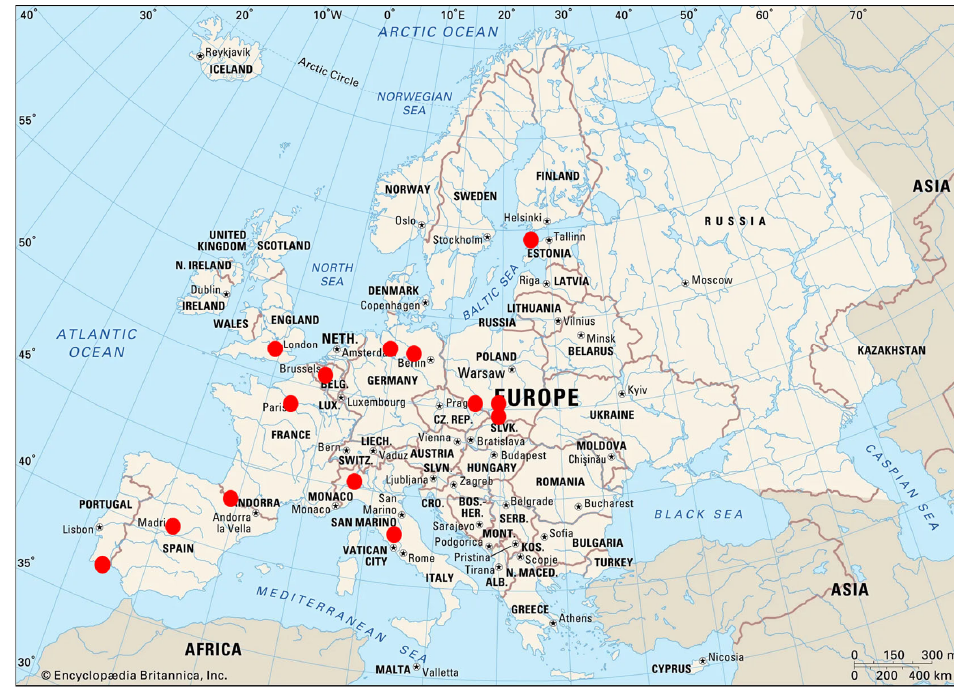
Figure 2. Location map. Own elaboration from Encyclopedia Britannica, Inc. As this is a prospective study, the cases selected for the analysis are diverse and het ‐ erogeneous to show the different forms of action taken in the renovation carried out in these European railway stations. Table 2. Basic data of the elements under study. Own elaboration.